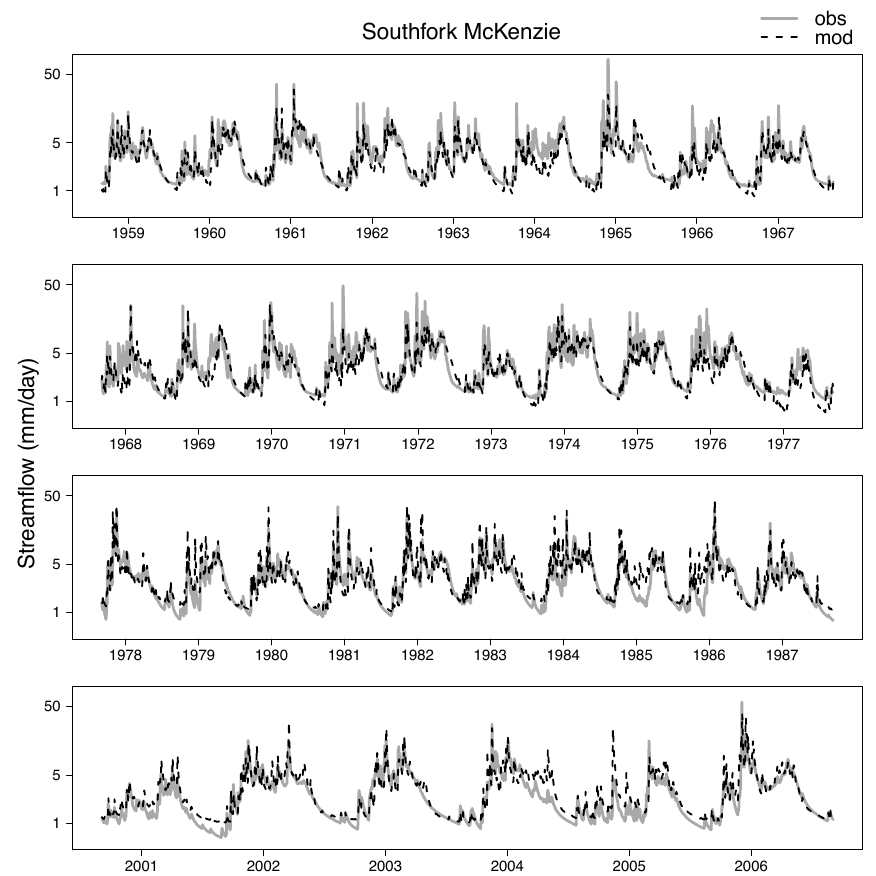
Fig. 4. Southfork watershed streamflow, modeled and observed. Modeled streamflows are generated using geologic end-members to assign soil drainage